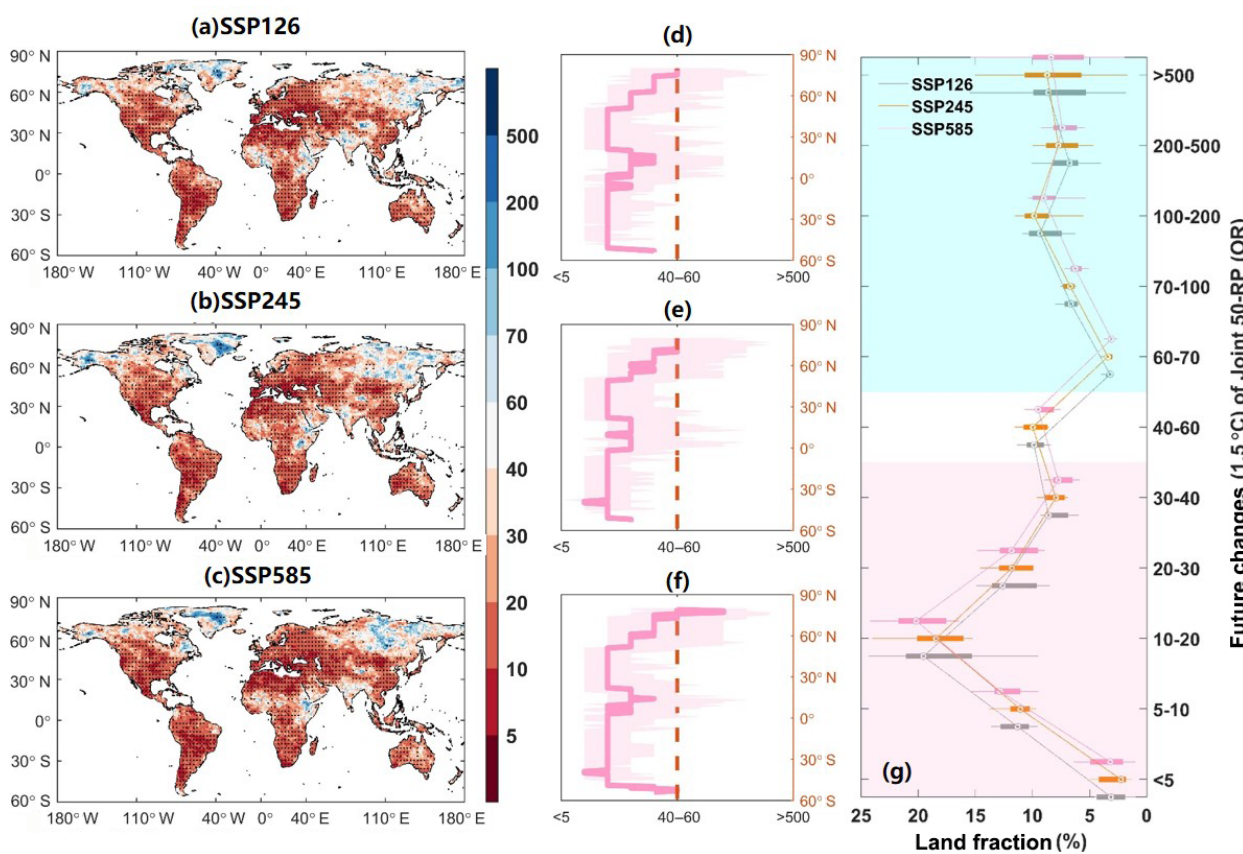
Figure 7. Projected changes in joint 50-year return periods of droughts under the 1.5 ◦ C warming